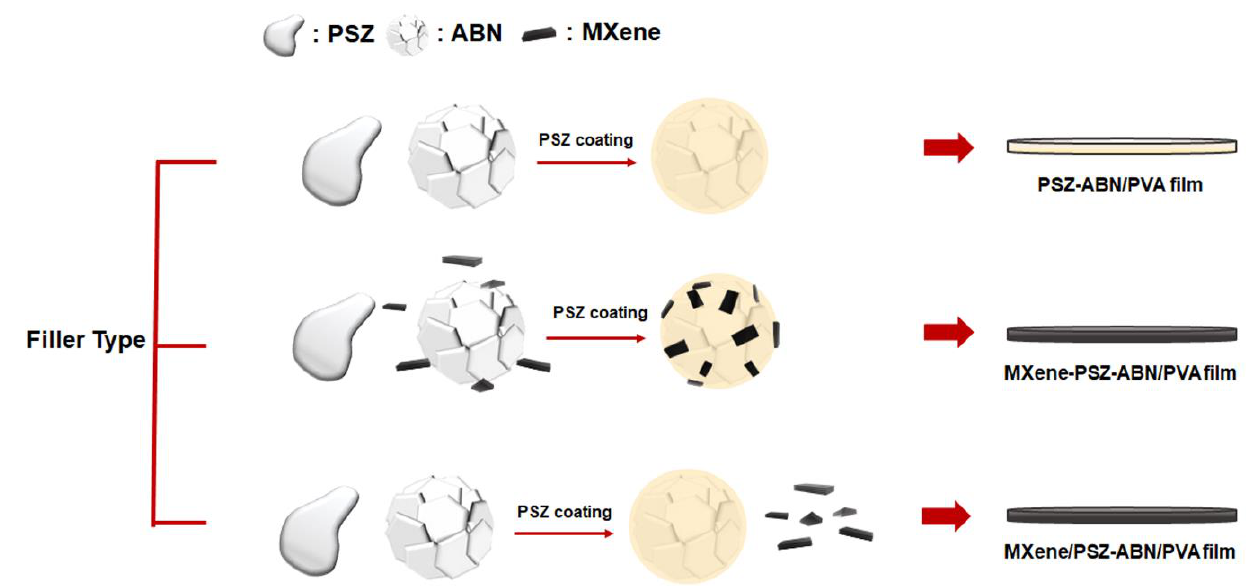
Figure 1. The schematic diagram of the composite fabrication routes.